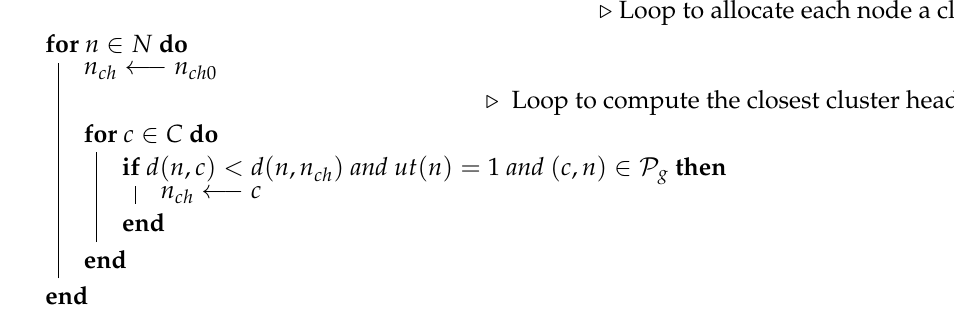
Algorithm 2: Distance-aware cluster